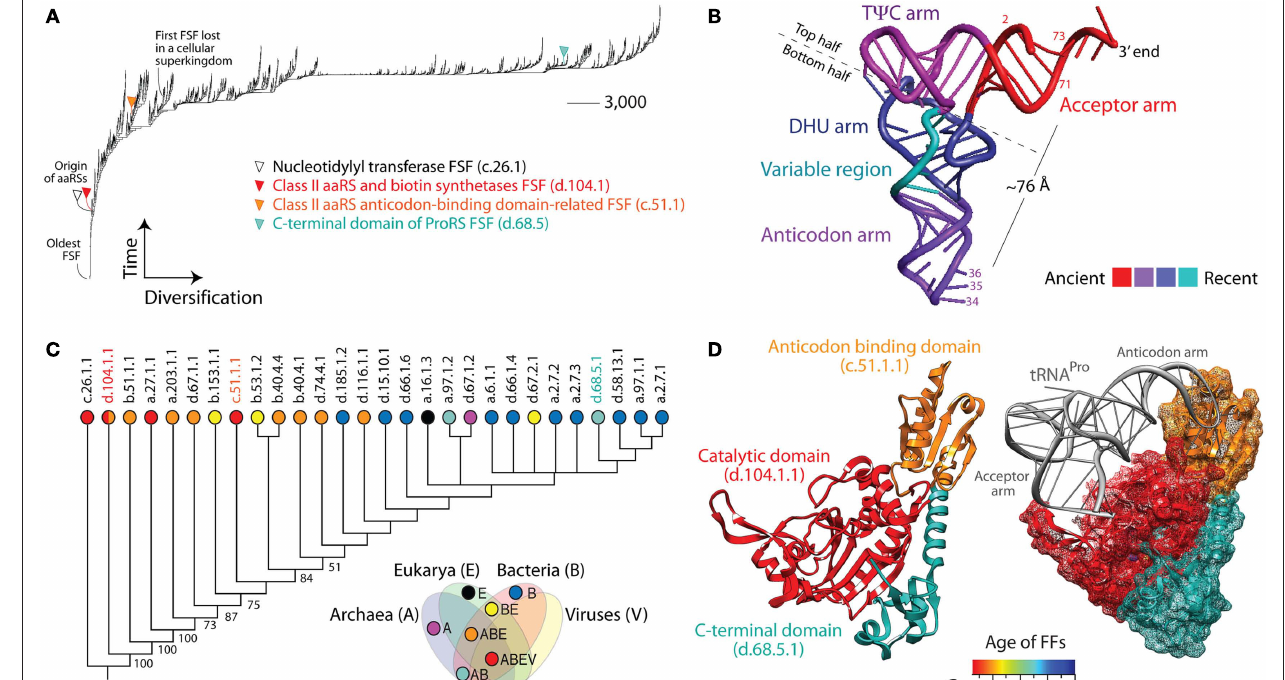
superkingdoms, Archaea (A), Bacteria (B), and Eukarya (E), and in viruses (V; e.g., families present in viruses are in red and correspond to the taxonomical